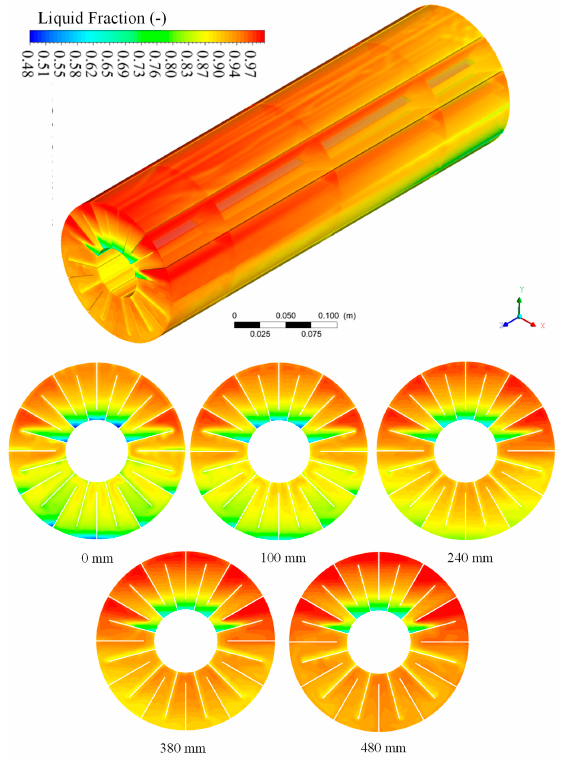
Figure 14. PCM liquid fraction distribution for 90% of volume in a liquid state (t = 4942 s).